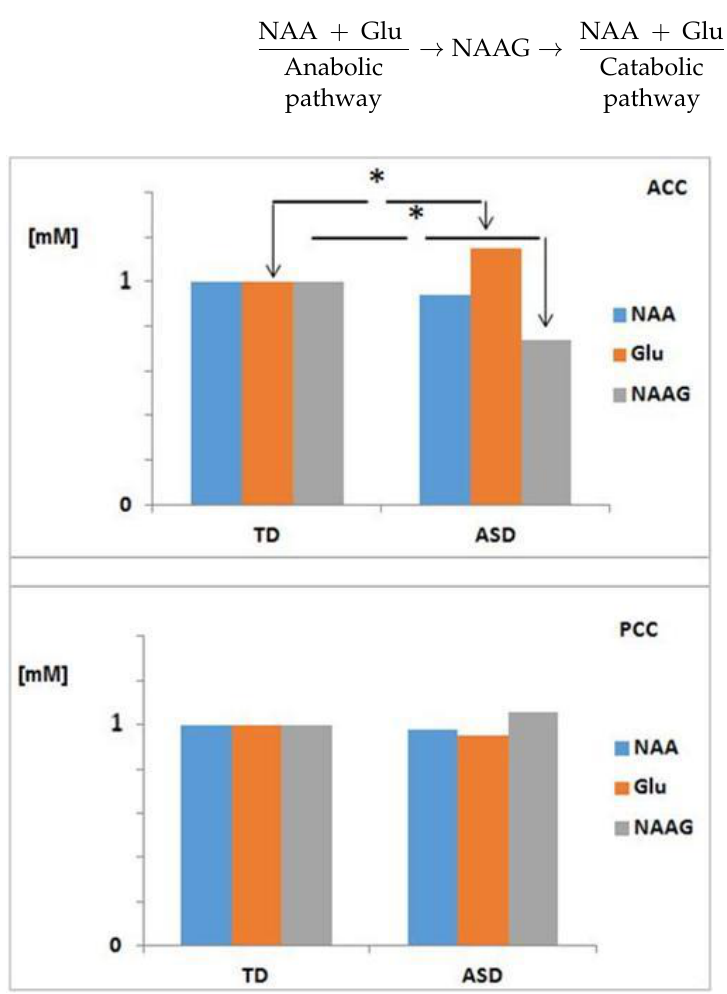
Figure 4. Differences in the means of the normalized absolute concentrations of NAA, NAAG, and Glu in ASD ( n = 22) and TD ( n = 43), in both the ACC and the PCC. * p < 0.05 considered significantly different. p < 0.05 considered significantly different. *, significant at p < 0.05,